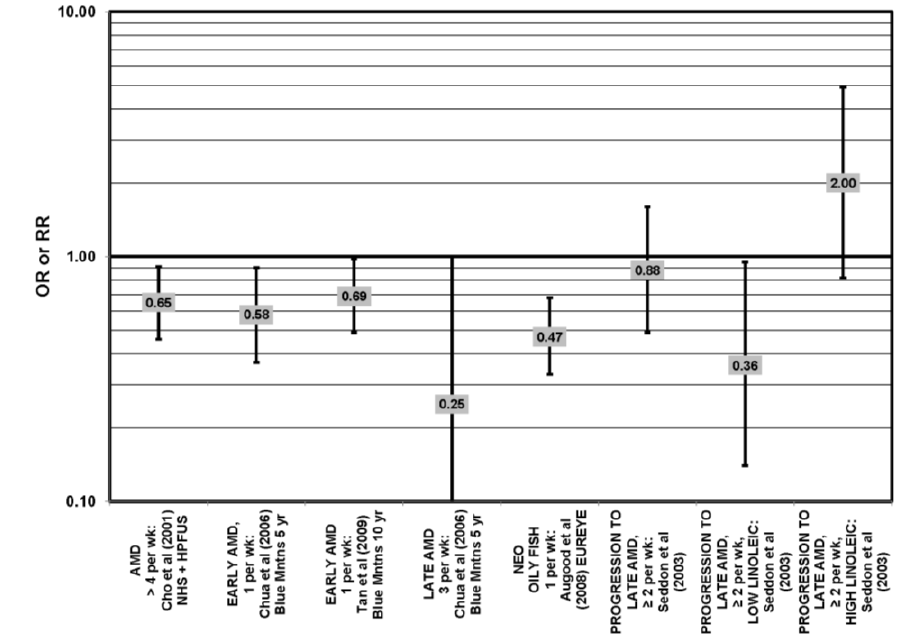
or neovascular (NEO) AMD and fish intake: prospective